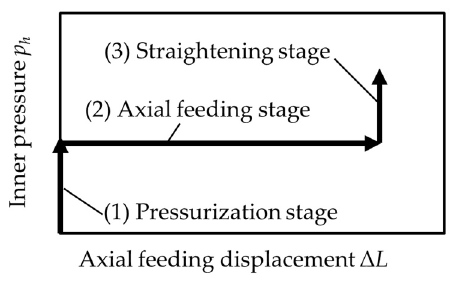
Figure 20. Schematic of the modified loading path used for the experiment and FEM.